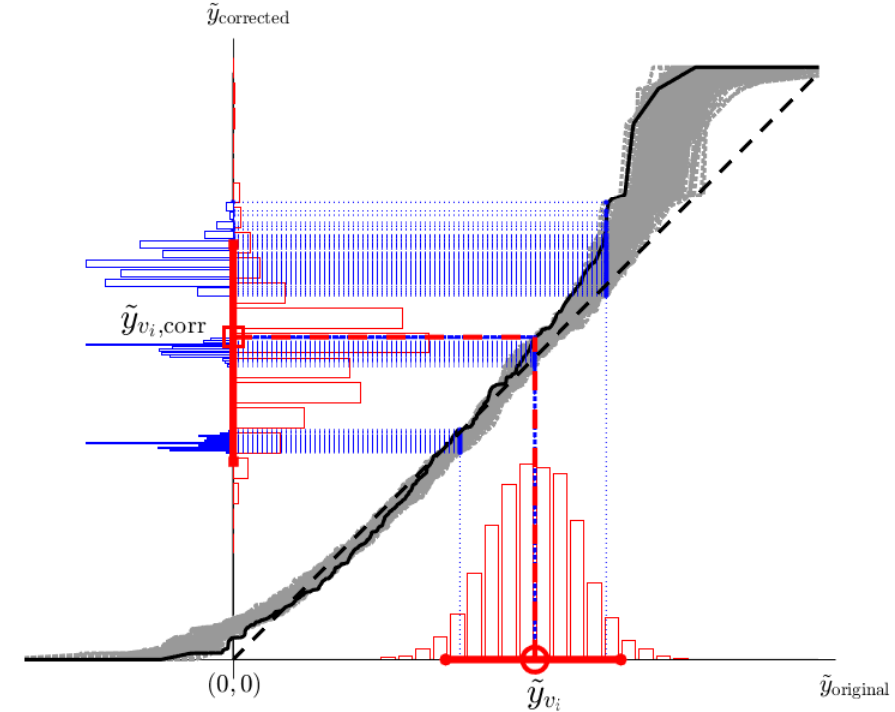
Figure 3. Sampling-based transformation of the raw prediction distribution: Prediction sample (red histogram on x-axis) with mean value (red circle) and the 95% probability interval (thick red line on x-axis), transformation curve with mean values (black line) and sampled transformation curves (gray lines), three individual examples of raw distribution sample point transformation (blue dashed lines) and their distributions (blue histograms), and the transformed prediction distribution (red histogram on y-axis) with the transformed mean value (red square) and the 95% probability interval (thick red line on